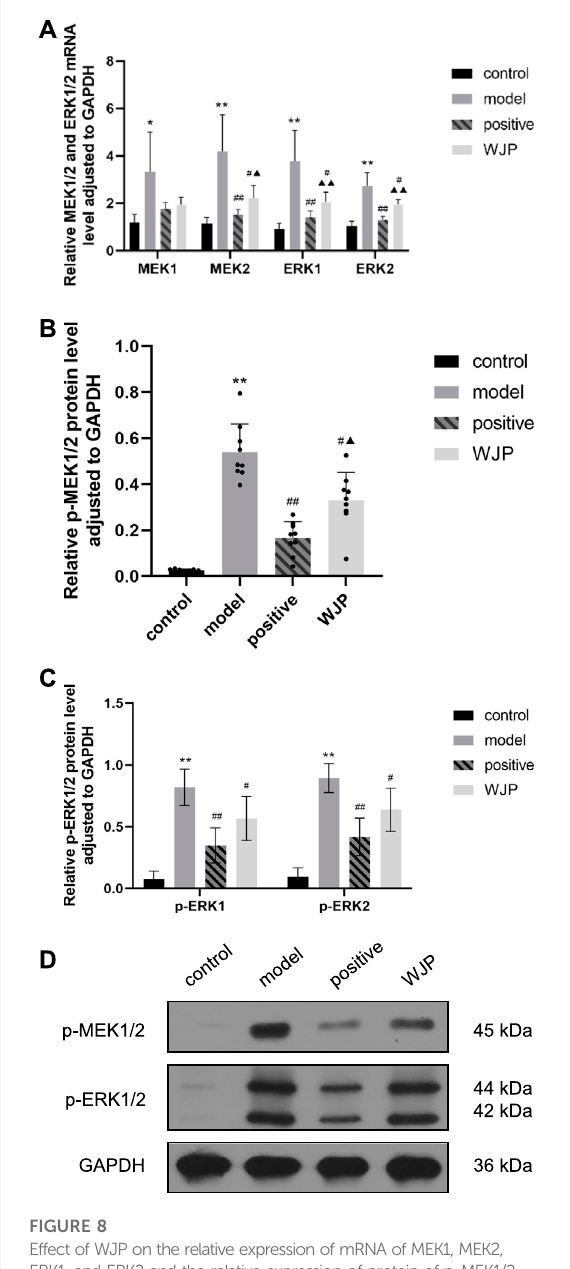
FIGURE 7 Effect of WJP on the relative expression of mRNA of MEK1, MEK2, ERK1, and ERK2 and the relative expression of protein of p-MEK1/2, p-ERK1, and p-ERK2 in the colon in the four groups. (A) The relative expression of mRNA of MEK1, MEK2, ERK1, and ERK2. (B) The relative expression of protein of p-MEK1/2. (C) The relative expression of proteinofp-ERK1andp-ERK2. (D) Westernblotanalysis.* p < 0.05;** p < 0.01, versus the control group. # p < 0.05; ## p < 0.01, versus the model group. ▲ p < 0.05; ▲▲ p < 0.01, versus the positive drug group.